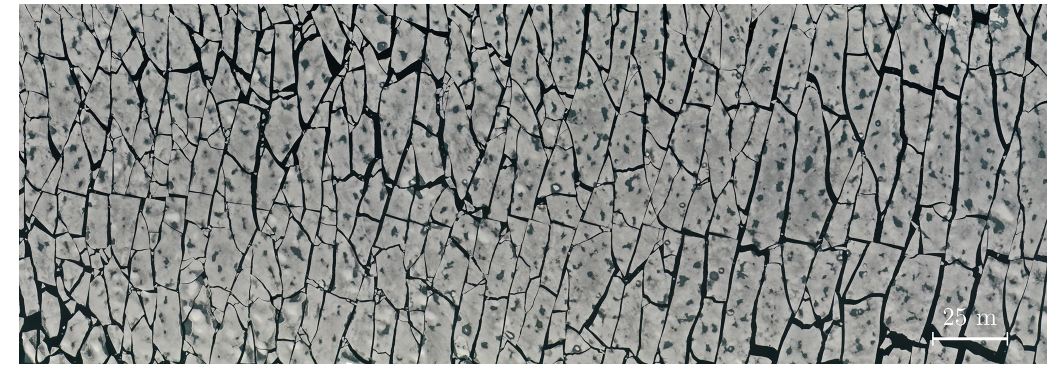
Figure 8. Partial view of the breakup resulting from the NBB experiment, corresponding to the green rectangle in Fig. 2.